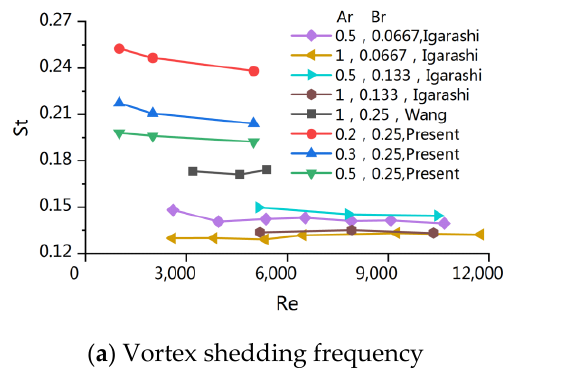
11 of 20 Figure 7. Space–time contour plots of streamwise velocity: ( a ) Ar = 0.2, Re = 1000; ( b ) Ar = 0.3, Re = 1000; ( c ) Ar = 0.5, Re = 1000; ( d ) Ar = 0.2, Re = 2000; ( e ) Ar = 0.3, Re = 2000; ( f ) Ar = 0.5, Re = 2000; ( g ) Ar = 0.2, Re = 5000; ( h ) Ar = 0.3, Re = 5000; ( i ) Ar = 0.5, Re = 5000.